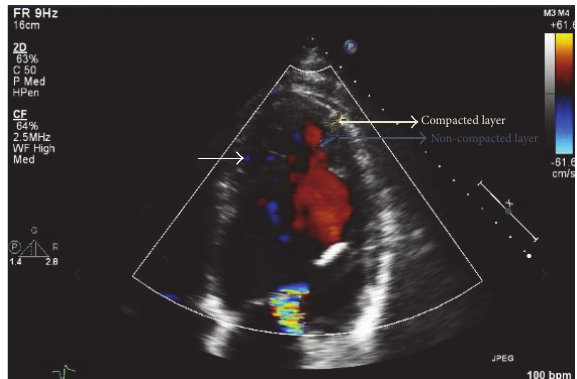
Figure 3: Color doppler echocardiogram demonstrating blood flow in the deep intertrabecular space (white arrow). Also, blue marking on the left ventricular wall showing noncompacted layer measuring 9.6 mm and yellow marking showing compacted layer measuring 4.4 mm with resulting ratio of noncompacted to compacted layer > 2 at the end of systole.